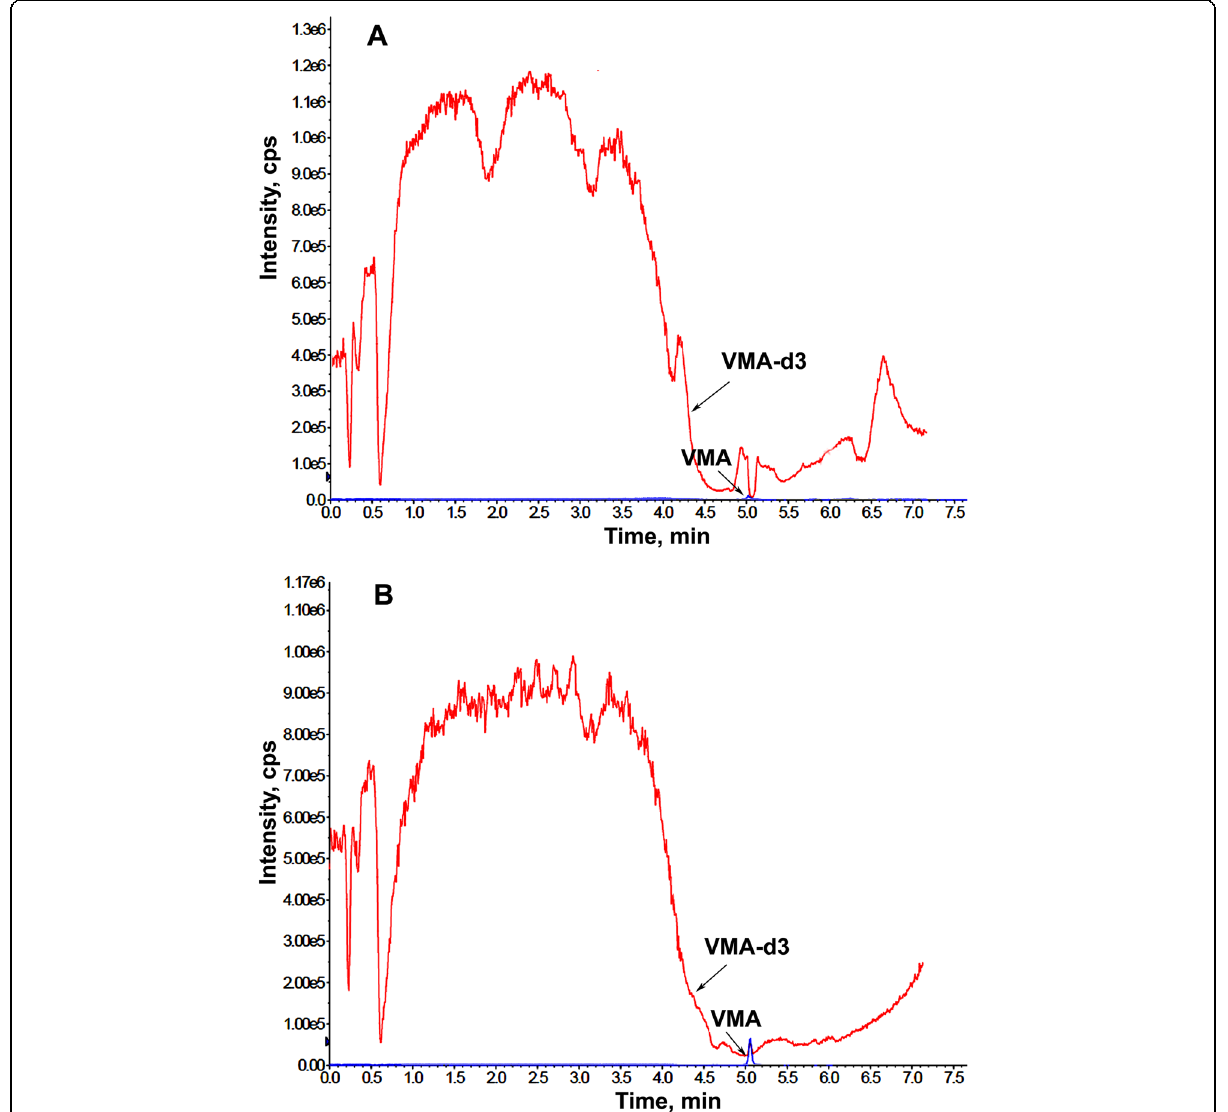
Fig. 5 Mitigation of VMA signal suppression by the MEPS approach. a Dilute-and-shoot approach. b MEPS approach. VMA-d3 was infusion